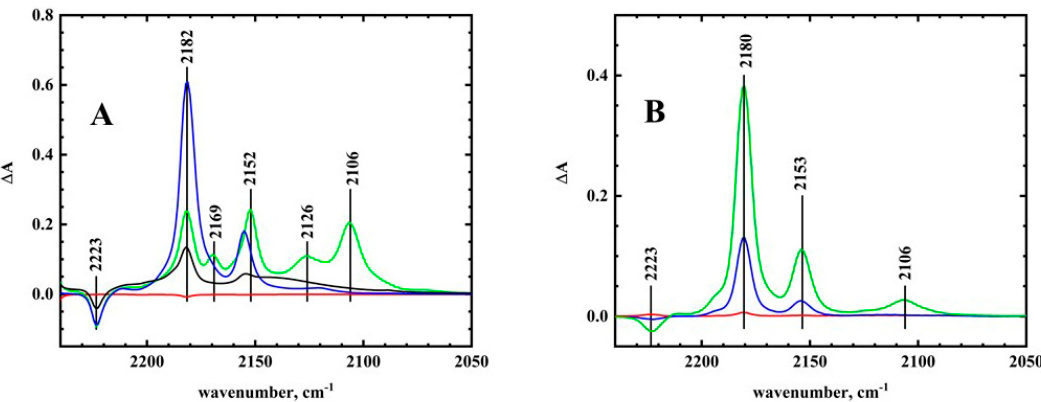
Figure 5. Infrared spectroelectrochemistry of TCNQ. ( A ) In acetonitrile. Initial difference spectrum (red); TCNQ − (blue); TCNQ 2 − (green); end of scan (black). Electrolyte: 0.10 M TBAP ( B ) In BMImBF 4 . Initial difference spectrum (red); TCNQ − (blue); TCNQ 2 − (green).